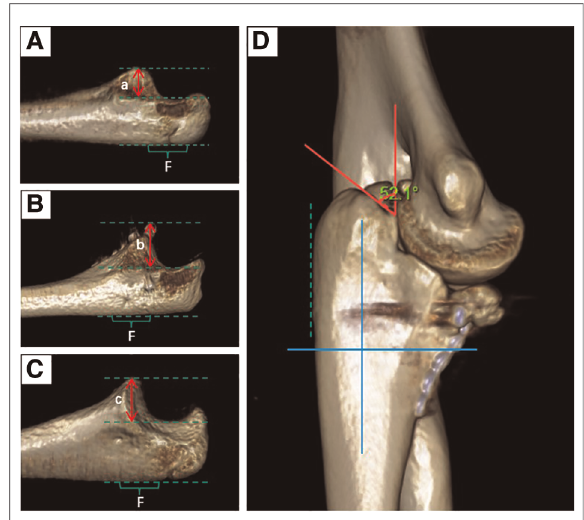
FIGURE 2 Parameters of the coronoid process of the ulna and the tip of the olecranon. ( A ) represents the height of the coronoid process of the ipsilateral ulna preoperatively; ( B ) represents the height of the coronoid process of the ipsilateral ulna postoperatively; ( C ) represents the height of the unaffected coronoid process; ( D ) shows that the osteotomy angle of the olecranon is about 52.1°. ( a / c =0.875, b / c =1.2). F is a fl at spot in the proximal ulna. The three dashed lines represent the highest point of the coronoid process of the ulna, the lowest point of the sigmoid notch, and the level of the fl at spot (green lines). The 0° angle runs parallel to the fl at spot of the corresponding olecranon, and is de fi ned by the constructed coordinate system (blue lines).